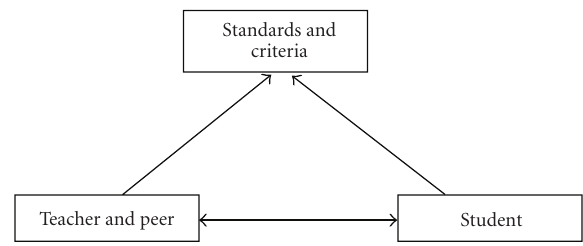
Figure 3: Students possess independent understanding and inter- pretation of